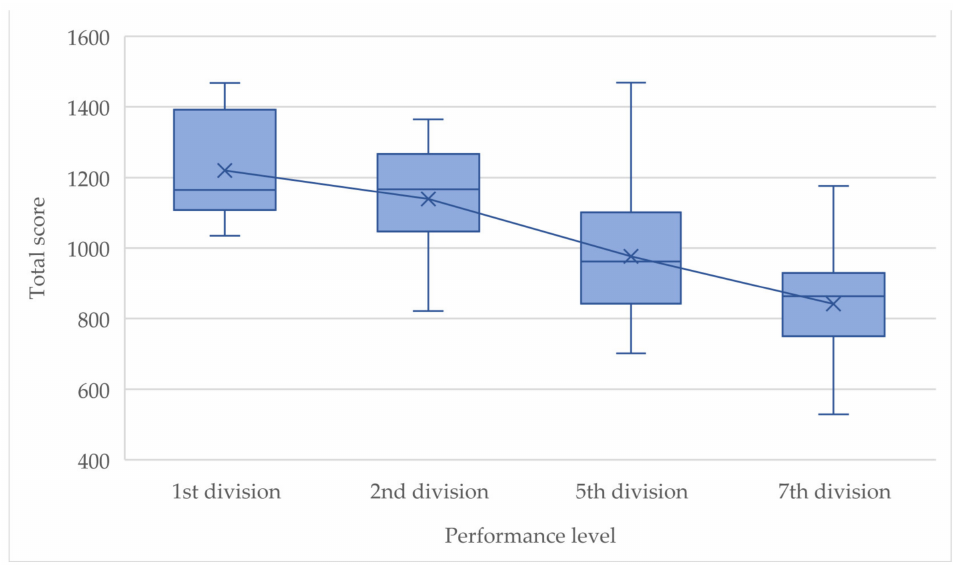
Figure 3. Boxplots of total score by performance